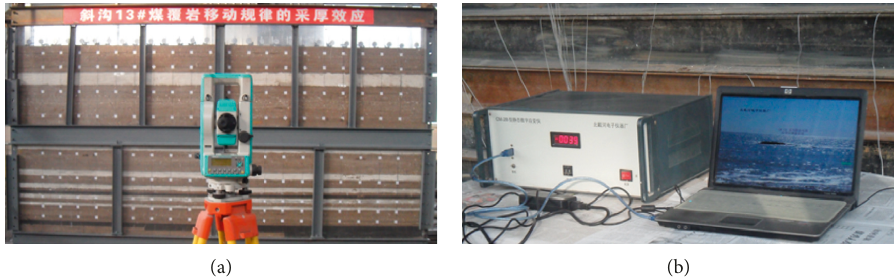
Figure 3: Test system. (a) The diagram of displacement measuring points and displacement measured by the total station. (b) The connection of strain brick and testing